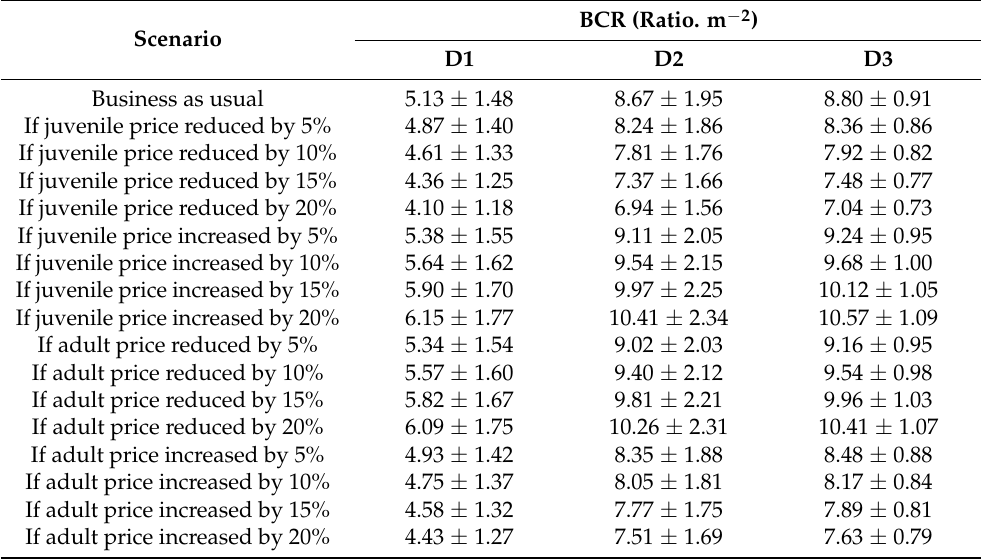
Table 3. The sensitivity analysis of the BCR (mean ± SE) to variations in the juvenile P. clarkii price and adult P. clarkii